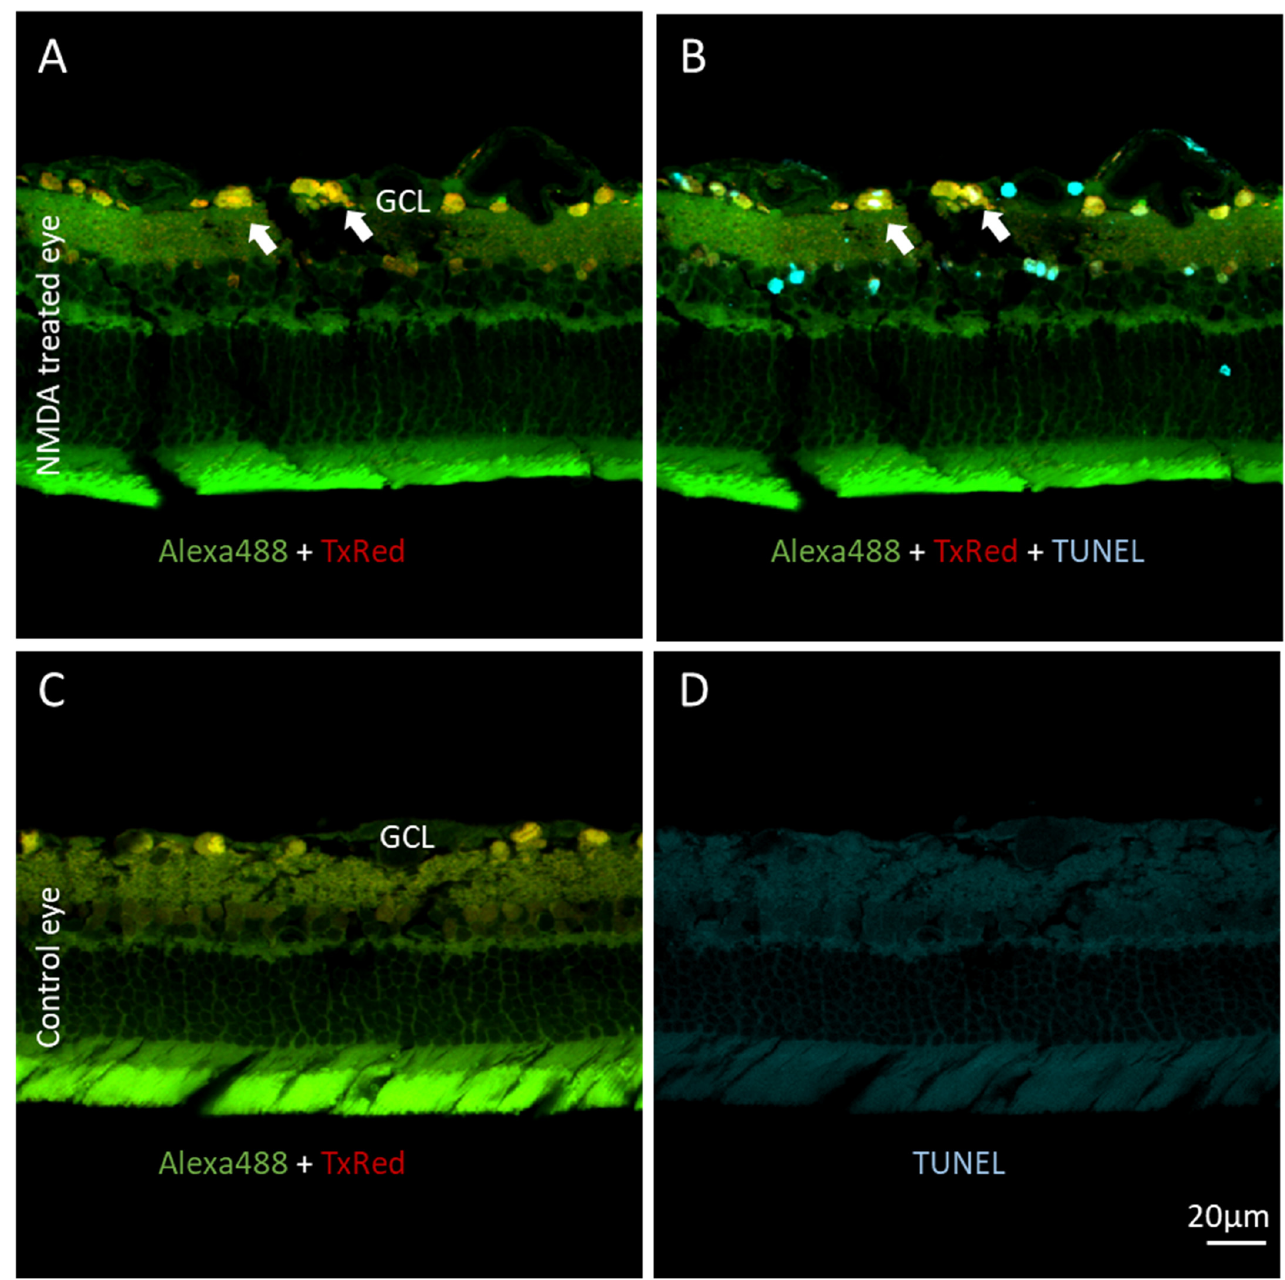
Figure 4. As previously reported, the mild NMDA model yields cell death in the GCL and KcapTR488 activation. GCL cells in vivo colocalize with TUNEL-positive labeling. Rat eyes were either treated with NMDA for 24 h ( A , B ) or untreated ( C , D ). Both eyes then had an intravitreal injection of KcapTR488 for 2–6 h and were excised. The arrows in images ( A , B ) point to the same set of repre- sentative cells that demonstrate the nuclear cytoplasmic separation of the red and green signal and positive TUNEL staining. In the untreated eye ( C , D ), GCL cells were evenly labeled in yellow and had no positive TUNEL labeling. Scale bar (20 µ m) in ( D ) applies to ( A – D ). Ganglion cell layer